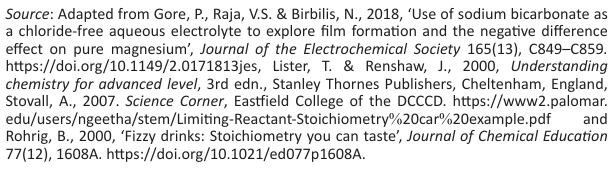
FIGURE 3: Chemical reactions that occurred in the infusion. Equation 1 (Gore, Raja & Birbilis 2018; Lister & Renshaw 2000), precipitation of calcium and